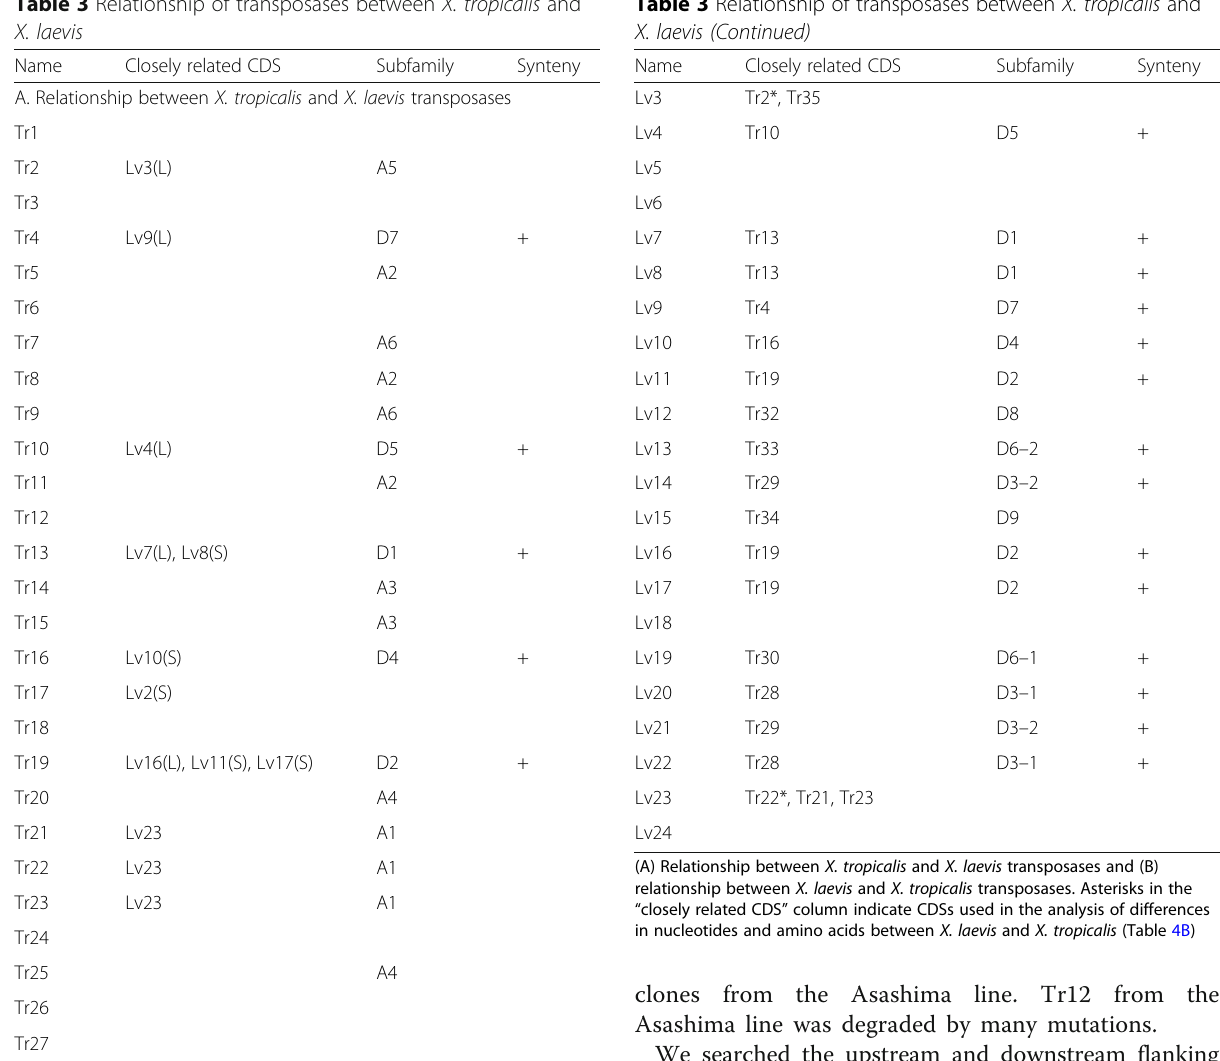
Table 3 Relationship of transposases between X. tropicalis and